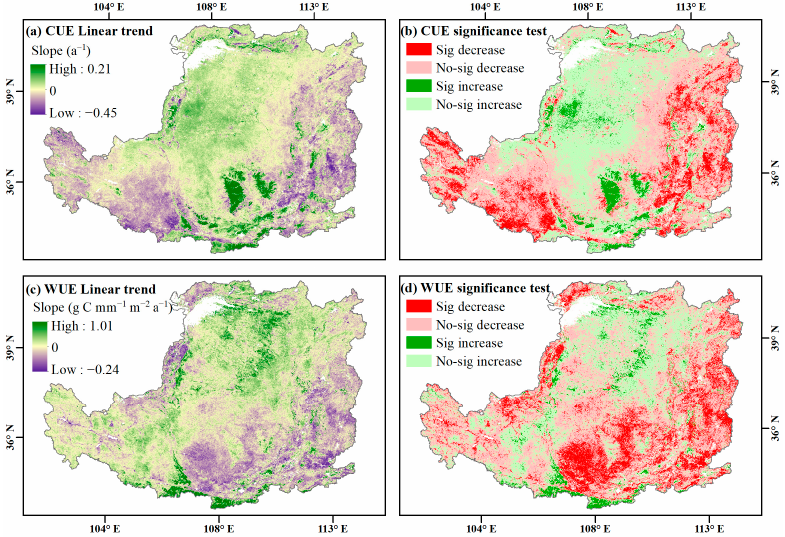
Figure 3. Spatial variation rate and its significance test of CUE ( a , b ) and WUE ( c , d ) from 2000 to 2020 in the Loess Plateau. in the Loess